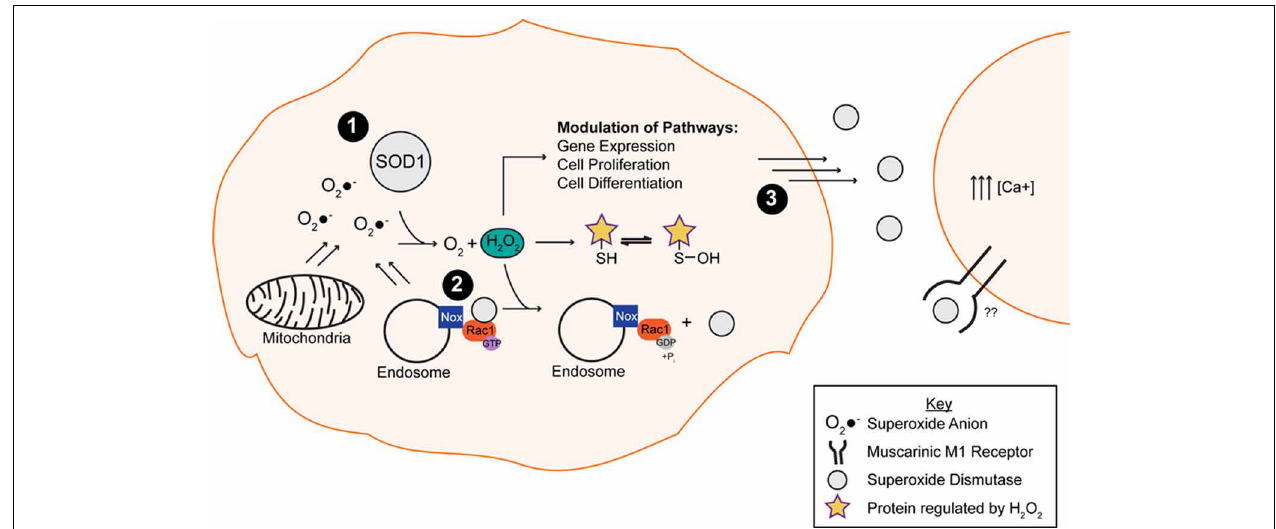
FIGURE 2 | The putative normal function of the native WT SOD1 protein. ( 1 ) SOD1 is responsible for converting the toxic superoxide anion (O 2 • − ) into oxygen (O 2 ) and hydrogen peroxide (H 2 O 2 ), the latter of which is involved in the modulation of multiple pathways through oxidation of exposed thiols. ( 2 ) SOD1 binds and stabilizes Rac1 in its active, GTP bound state, resulting in Nox2 (Nox) activation and superoxide production. The hydrogen peroxide